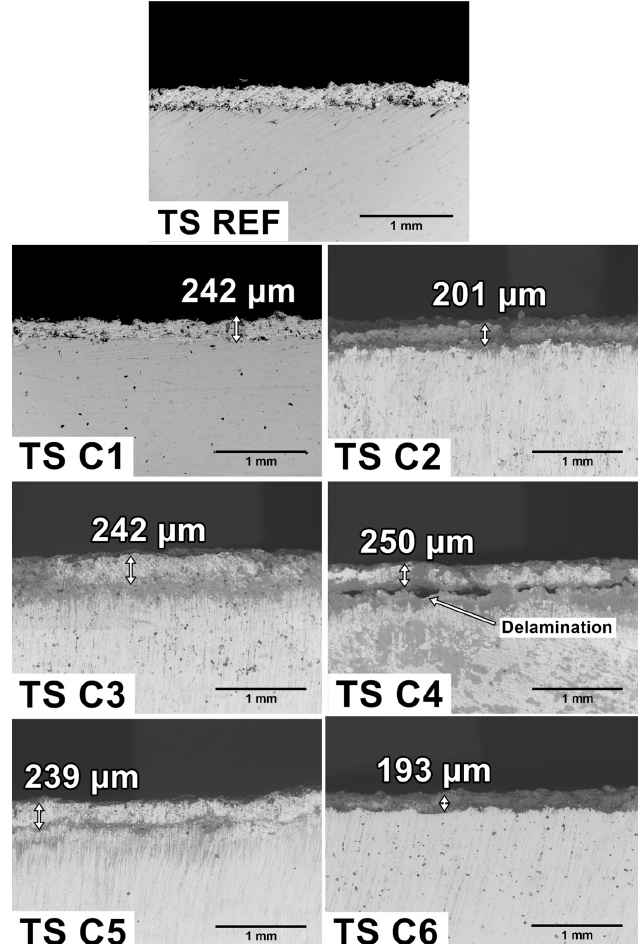
O coating by thermal spray (TS) samples exposed to immersion test. 2 5